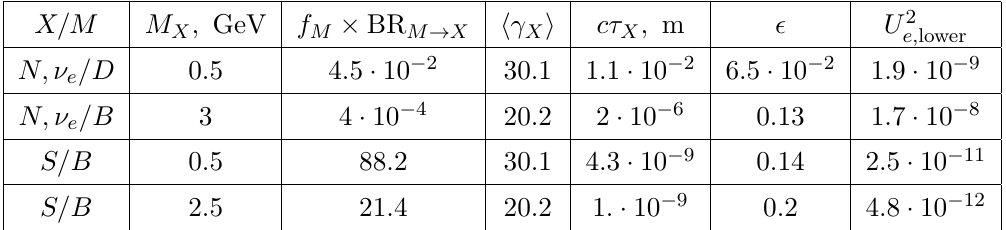
= 1, X = 2 : 3, where events ; lower